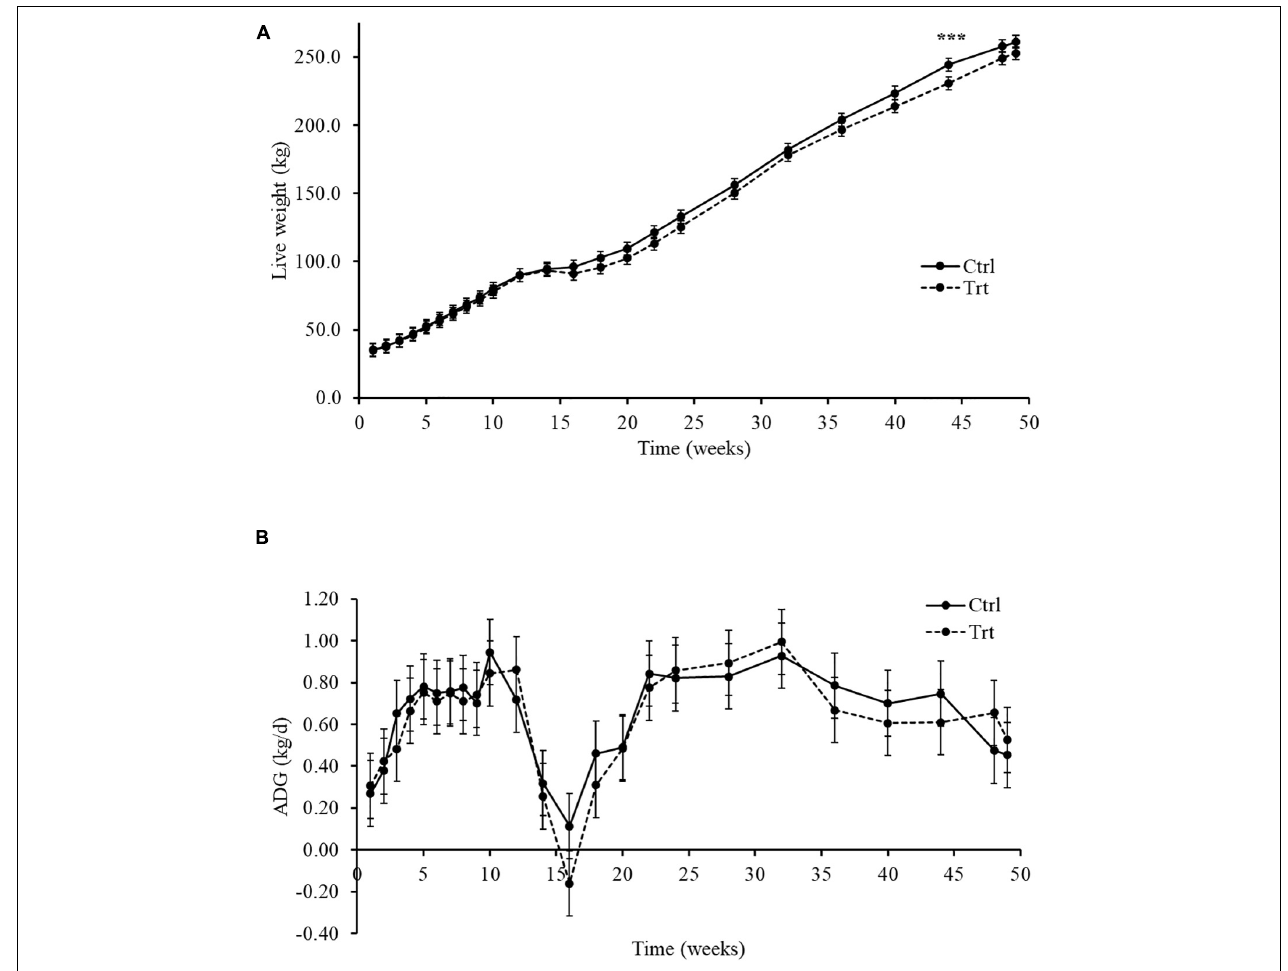
FIGURE 1 | Growth performance from week 1 to 49 in control group (Ctrl) and treated (Trt) calves. Growth performance was measure as: (A) Live weight (kg) and (B) average daily gain (ADG; kg/d). Calves during the rearing time were fed as follows: milk twice a day and ad libitum control and treatment concentrates at weeks 2 and 4; milk once a day and ad libitum control and treatment concentrates and partial mixed ration (PMR) diet at weeks 6, 8, and 10; concentrates step-down weaned and PMR diets fed ad libitum until week 14; and grazing a mixed sward of ryegrass/clover as one mob at weeks 24 and 49. Predicted means and their least square of the difference (LSD) are presented. Significance of pairwise comparisons (Tukey post-hoc analysis) between treatments are indicated by asterisks as: *** P <